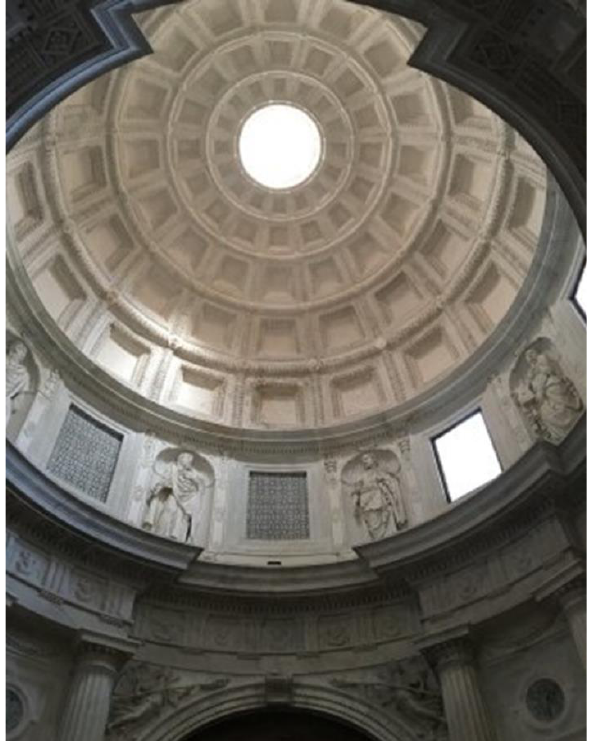
Figure 2. Naples, San Giovanni a Carbonara Church. The calotte of the Caracciolo di Vico Chapel (about 1499-1516)